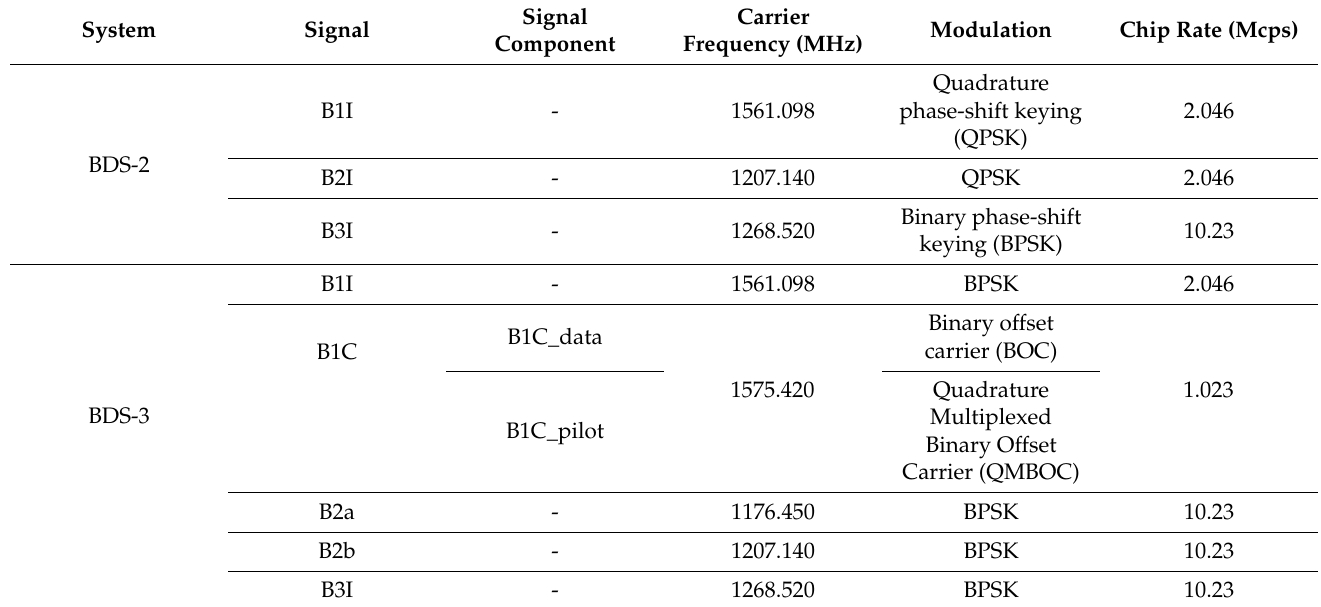
Table 1. The properties of the selected